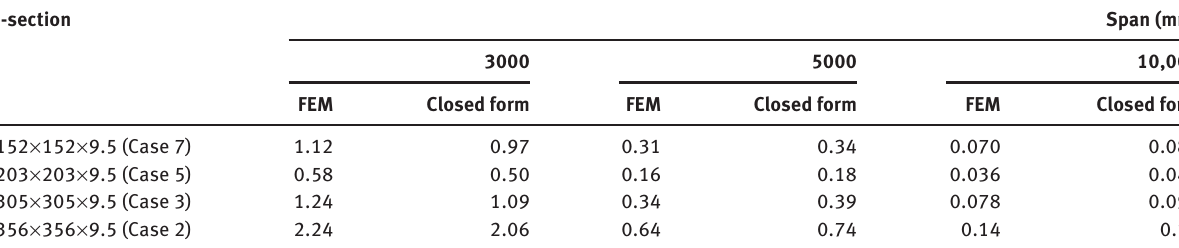
Table 12 Effect of the web (or flange) length on the normalized critical buckling stresses. I-section